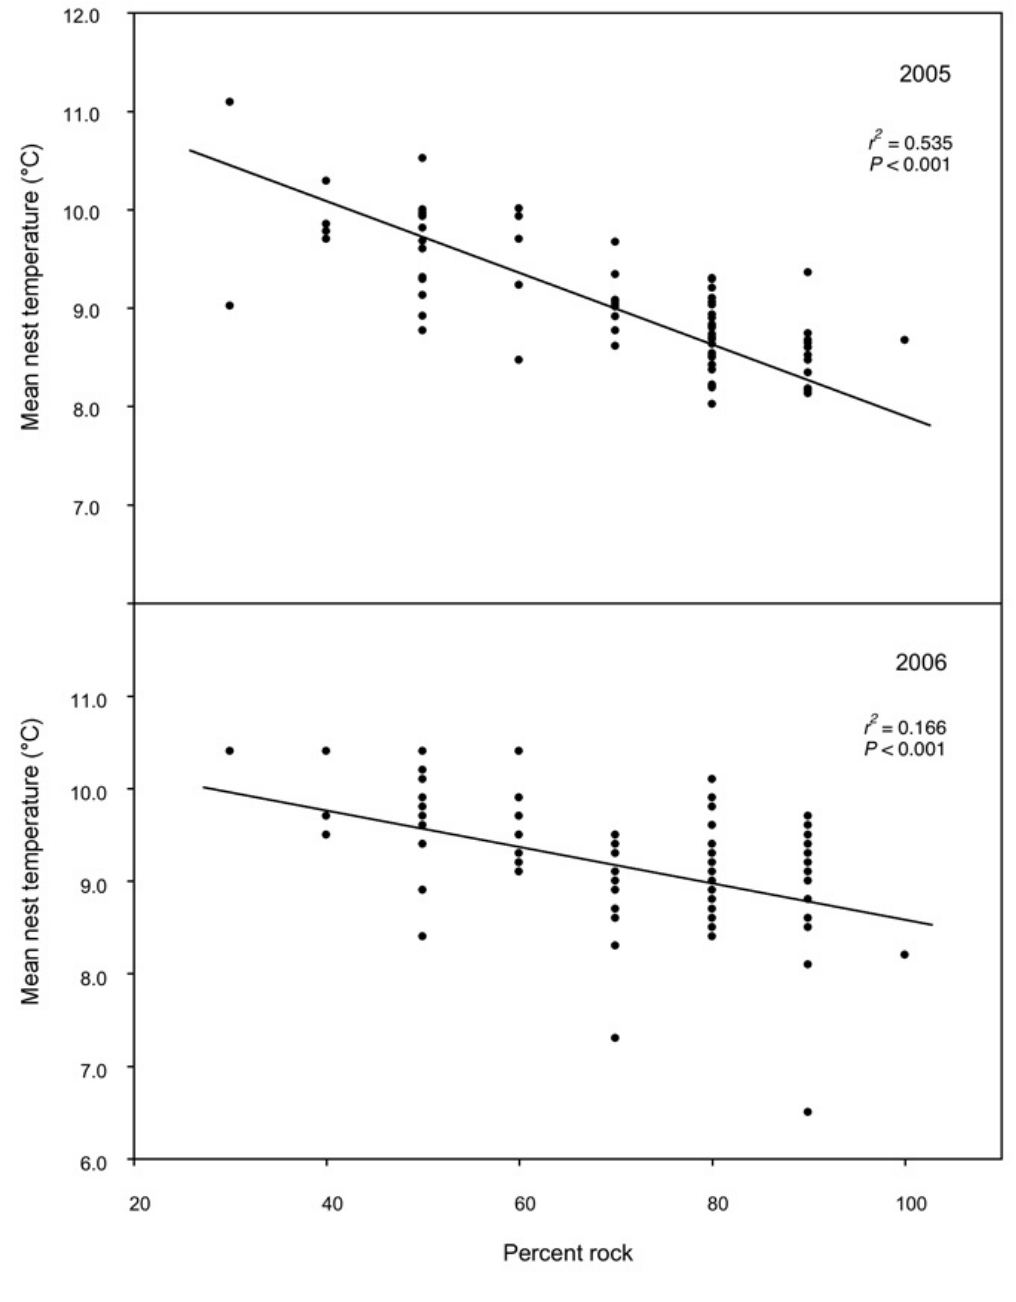
Fig. 3 . Inverse relationship between percent rock and mean nest temperature (°C) in Fork-tailed Storm- Petrel ( Oceanodroma furcata ) nests on Kasatochi Island, Alaska in 2005 and 2006. Lines are fit to untransformed data; statistics represent relationships between temperature and arcsine-transformed values of percent